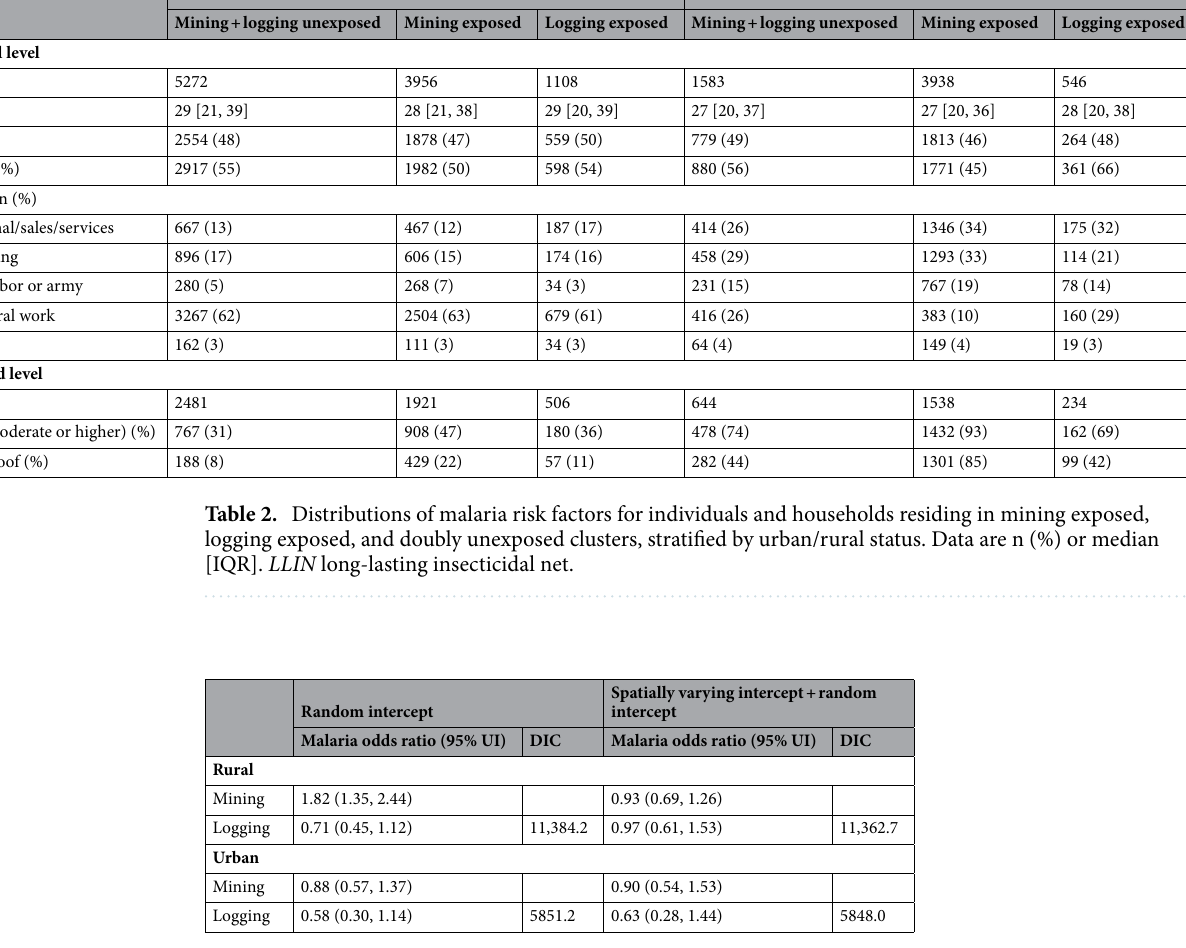
Table 3. Hierarchical logistic regression model results, non-spatial, and with a spatially varying intercept. All models adjusted for age, sex, LLIN use, temperature, precipitation, vegetation, elevation, and household wealth. UI uncertainty interval, DIC deviance information